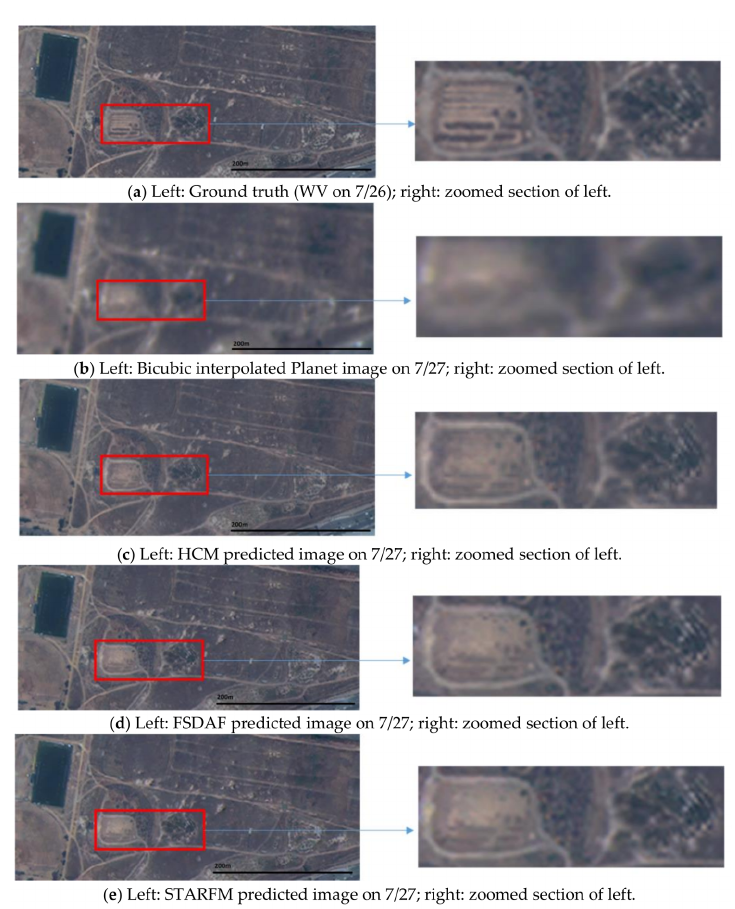
Figure 9. Comparison of different fused images with the ground truth (WV) and the low resolution Planet image at the prediction time. Field area.